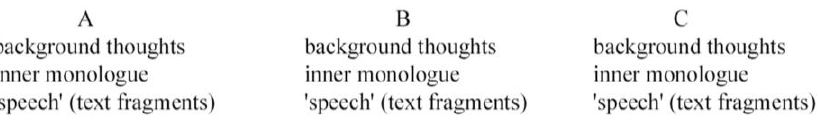
Figure 2. Narrative path.